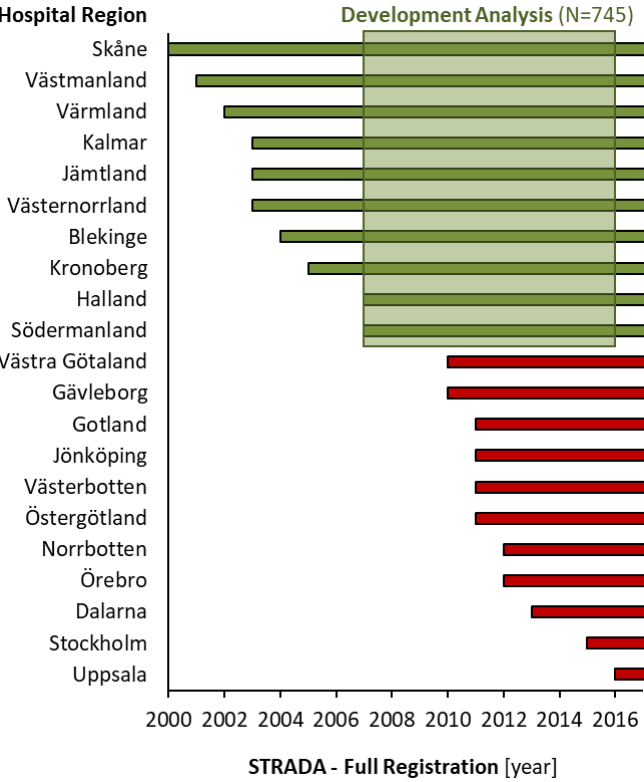
Figure 2. Hospital regions in Sweden including year they began reporting to STRADA. Green bars indicate that the region was used for the development analysis in the present study, covering the years 2007–2016. Red bars indicate that the region was excluded from the development analysis, since reporting to STRADA began after